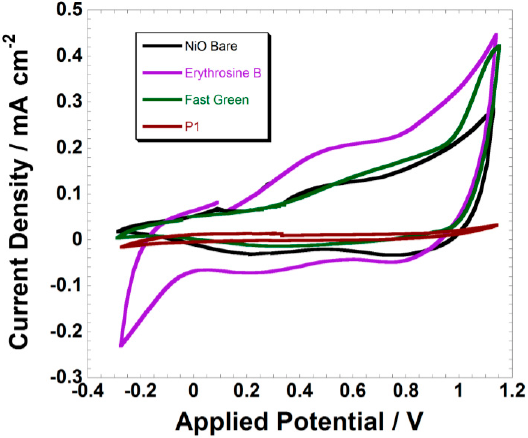
Figure 2. Variation of the voltammogram of screen-printed NiO electrodes in passing from the bare state (black trace) to the sensitized ones with ERY, FG, and P1 (see Figure S1 for the corresponding structures). Scan rate: 100 mV s − 1 .